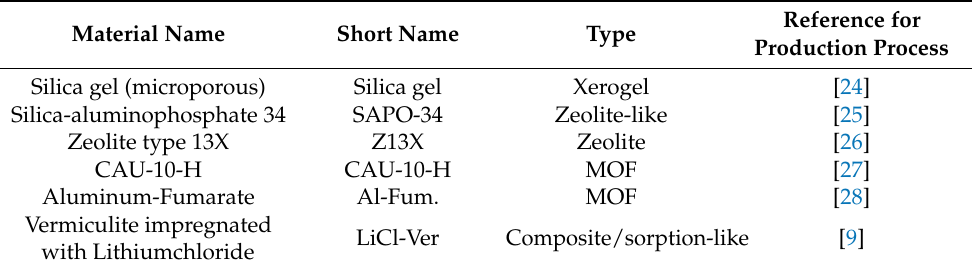
Table 1. Overview on investigated sorption materials; MOF: Metal Organic Framework.